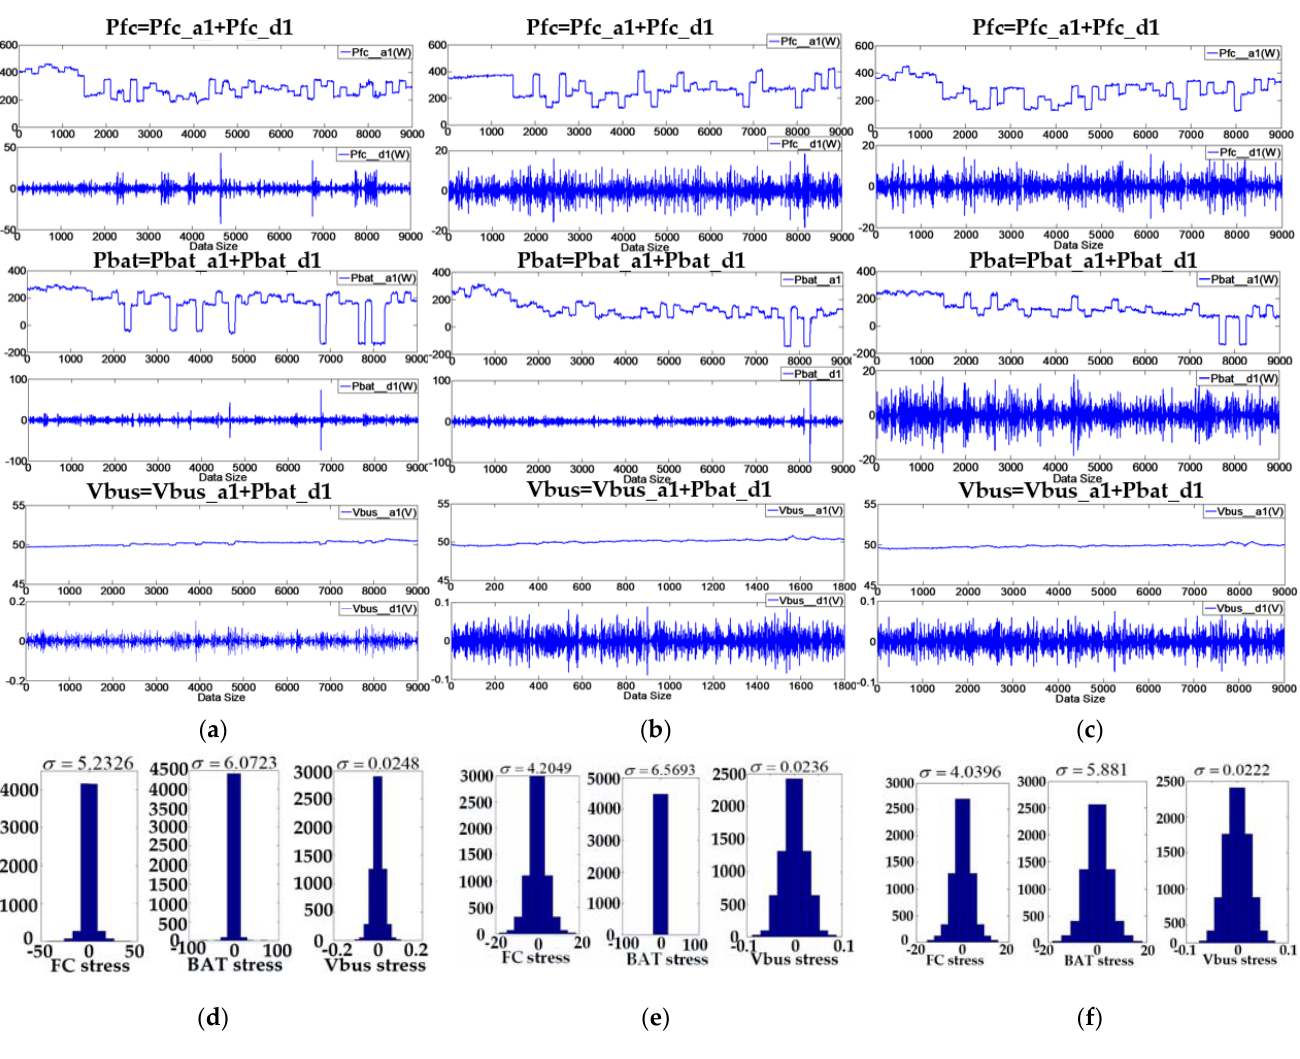
Figure 22. The decoupling results of the power response and DC voltage bus. ( a ) The decoupling results of power response and DC voltage bus with RB control. ( b ) The decoupling results of power response and DC voltage bus with FL control. ( c ) The decoupling results of power response and DC voltage bus with PSO-based FL control. ( d ) Stress analysis under RB control. ( e ) Stress analysis under FL control. ( f ) Stress analysis under PSO ‐ based FL control.